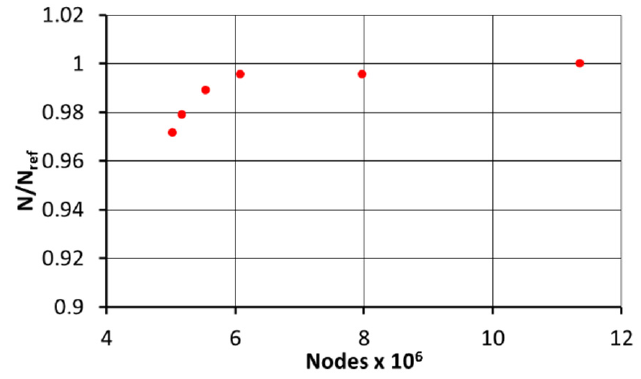
Figure 7. Global mesh study. Six meshes differing on the height of the first element were created in the second stage of the study. In all cases, the growth rate between consecutive cells was equal to 1.25 and a variable number of layers provided that the same distance from the wall was covered with an inflating mesh. The heights were: 5 · 10 − 5 mm, 10 − 5 mm, 5 · 10 − 4 mm, 10 − 3 mm, 4 · 10 − 3 mm and 8 · 10 − 3 mm. The four finest grids ensured maximal y + ≤ 1. It is shown in Figure 8 that results within 99.8% of accuracy were obtained for these meshes. Power obtained from the last two, for which y + > 16 and y + > 30 differed substantially. For the coarsest mesh, the power was more than two times underestimated, which proved a great significance of boundary layer discretization for the Tesla turbine modelling. The mesh with the first element height of 10 − 3 mm was